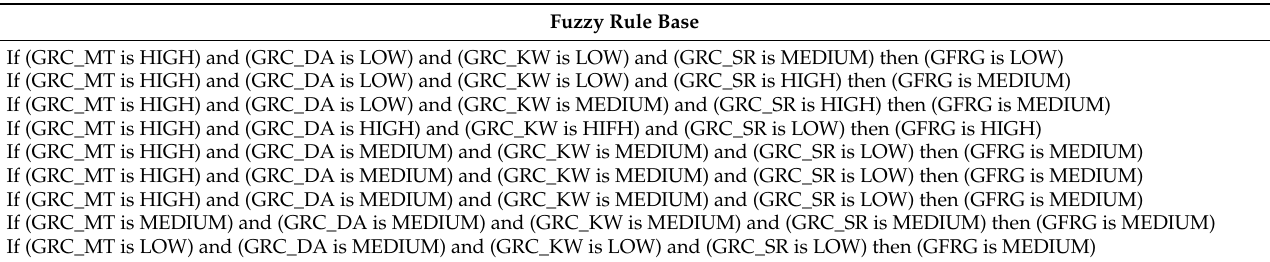
Table 7. Display rules using linguistic expressions. Fuzzy Rule Base